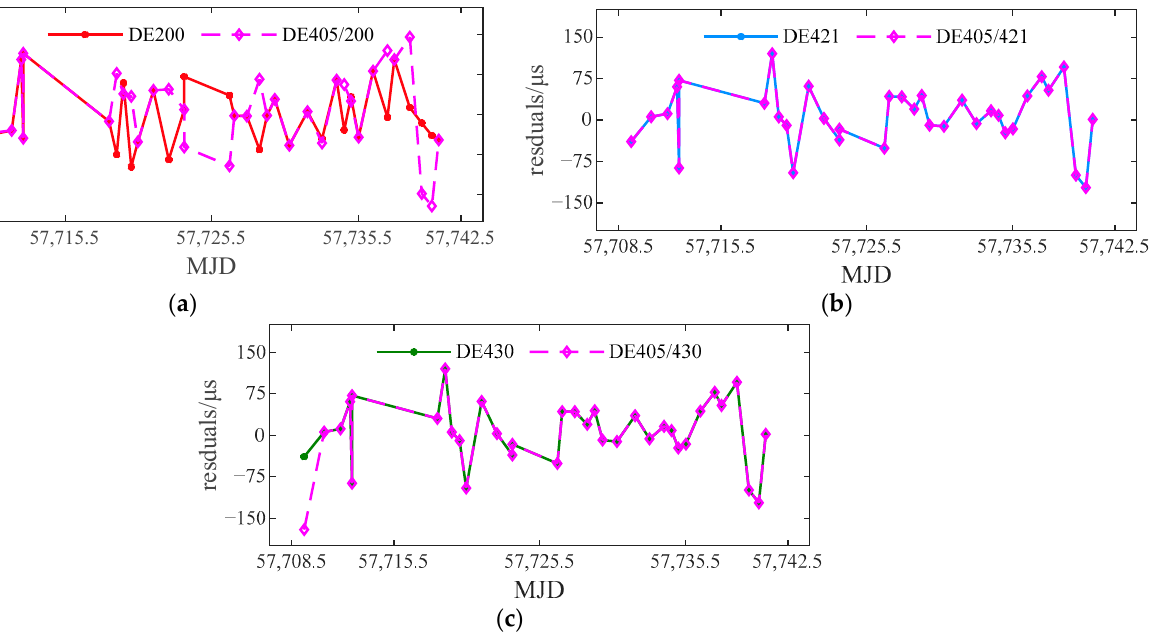
Figure 6. Timing residual using DE405 standard pulse profile. In ( a ), the red curve represents the